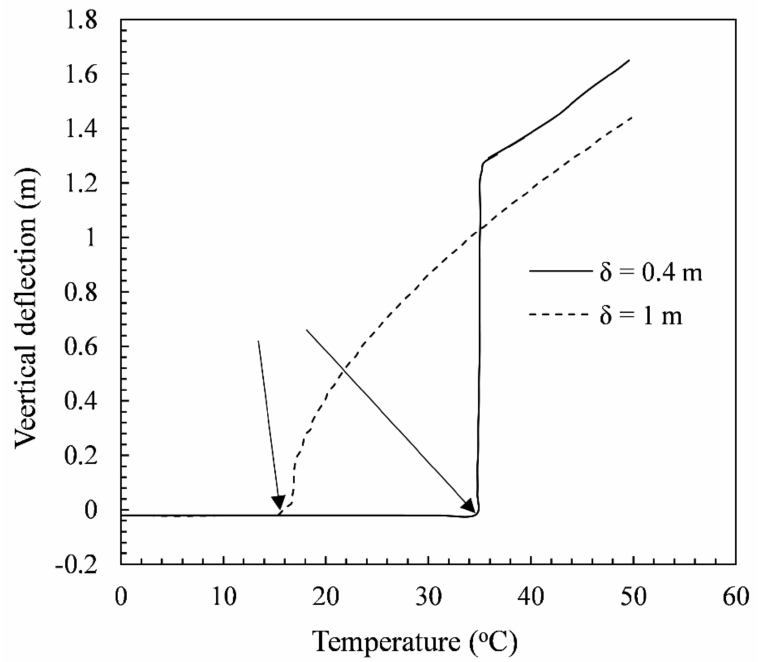
Figure 2. Variation of critical buckling temperature with vertical deflection for different initial imperfection